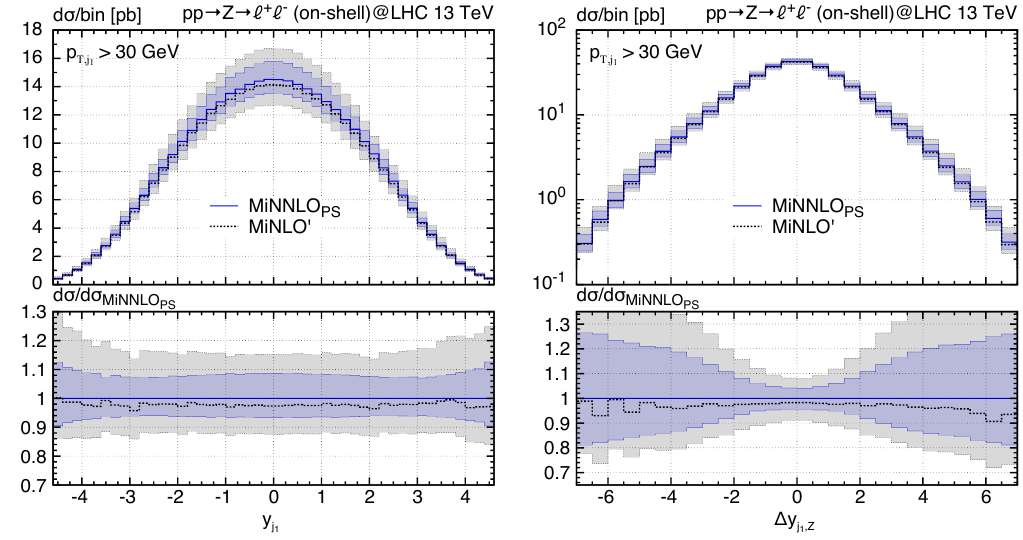
Figure 6 . Distribution in the rapidity of the leading-jet (left) and its rapidity di(cid:11)erence with the Z boson (right) for MiNNLO PS (blue, solid) and MiNLO 0 (black, dotted). each other in terms of shape. Again the MiNNLO uncertainty band is signi(cid:12)cantly PS smaller than the MiNLO 0 one, and we observe a rather constant correction, of the order of (cid:24) 5 (cid:0) 10%, due to the additional NNLO